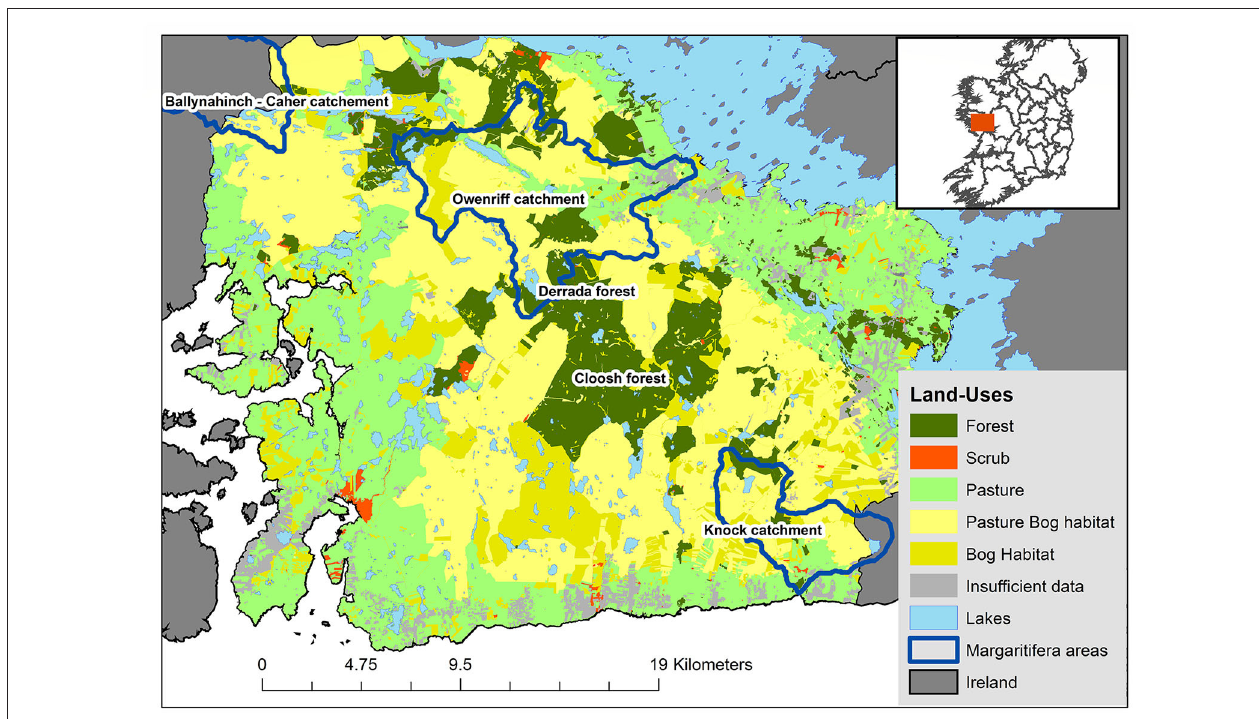
FIGURE 1 | The Barony of Moycullen CSA in County Galway, Ireland, delineated by its land-uses. Margaritifera areas are catchments with freshwater pearl mussel populations. The Cloosh Forest is the forest area at the center of the CSA, Derrada is located north of Cloosh. The Owenriff catchment contains much of the Derrada forest and is located just north of Cloosh. Source: Lundholm et al.